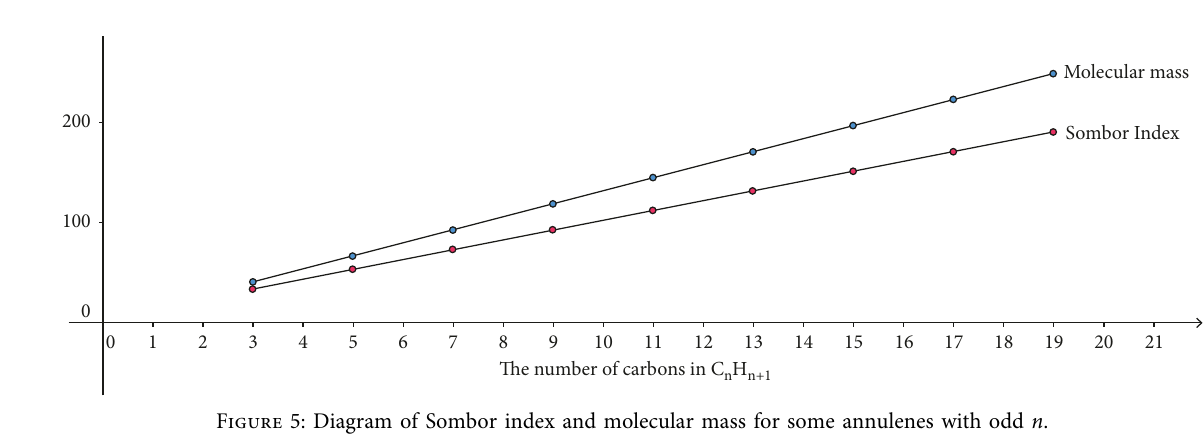
Figure 5: Diagram of Sombor index and molecular mass for some annulenes with odd n .